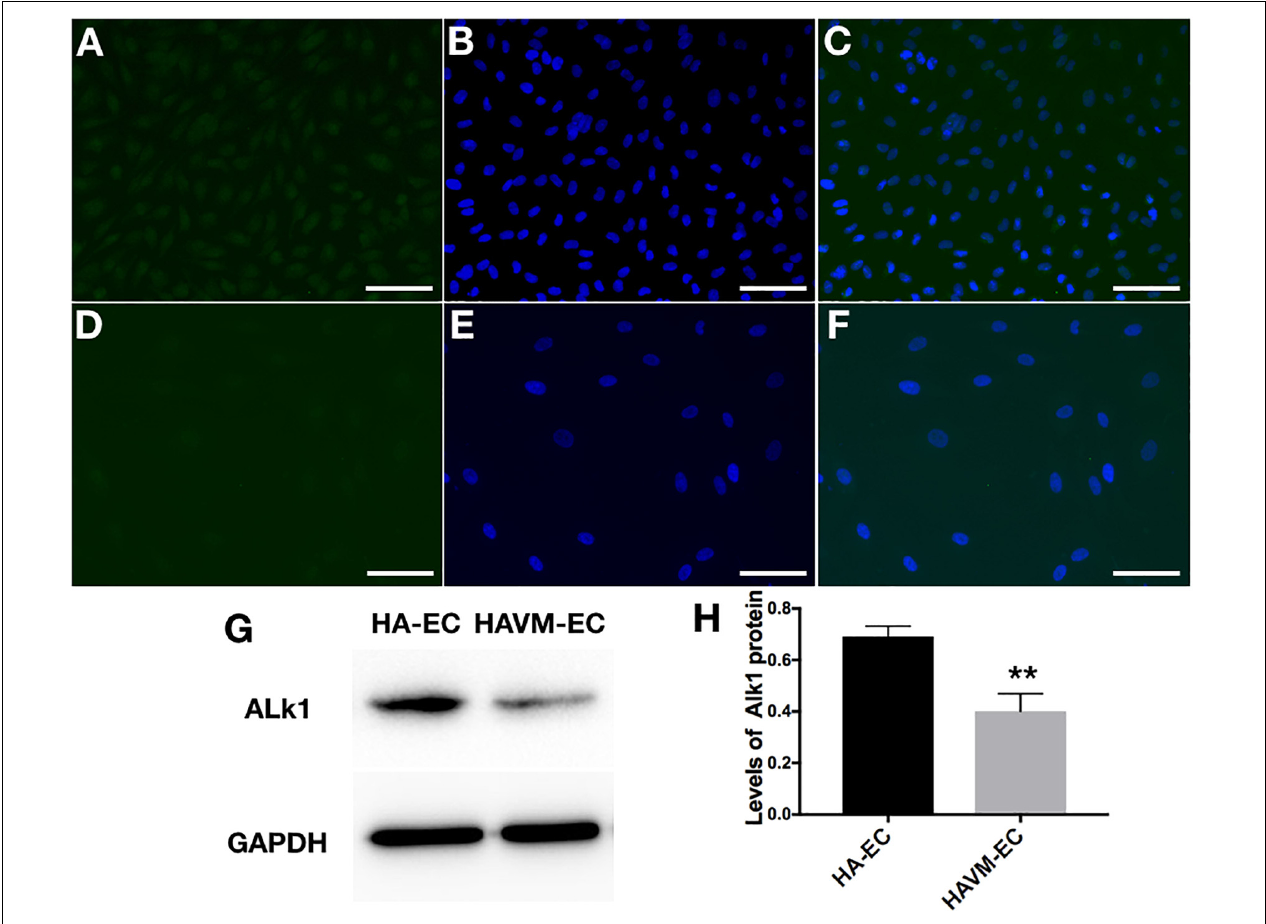
FIGURE 9 | Expression of Alk1 proteins in HA-ECs and cAVM-ECs. (A–D) Immunofluorescent staining to detect the Alk1 protein expressed in HA-ECs and cAVM-ECs. (A–C) In HA-ECs, (A) Alk1 protein was stained by Green fluorescent, (B) nuclei was stained by DAPI in Green fluorescent; (C) merge; (D–F) In cAVM-ECs, (D) Alk1 protein was stained by Green fluorescent, (E) nuclei was stained by DAPI in Green fluorescent; the fluorescence intensity in cAVM-ECs was obviously lower than in HA-ECs; (F) merge. Scale bar = 200 µ m; (G) Detect the expression of Alk1 by Western blot, (H) expression of Alk1 proteins in the HA-ECs cultures were significantly higher than that in cAVM-ECs in vitro ( ∗ p <